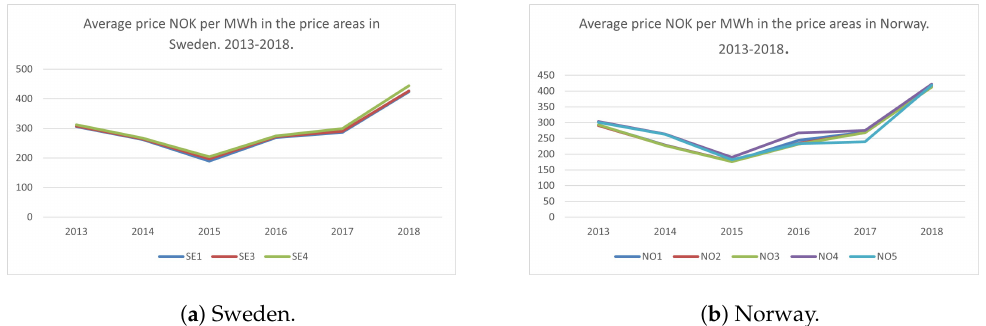
Figure 5. The average price in NOK per MWh in the price areas in Sweden and in Norway in the years